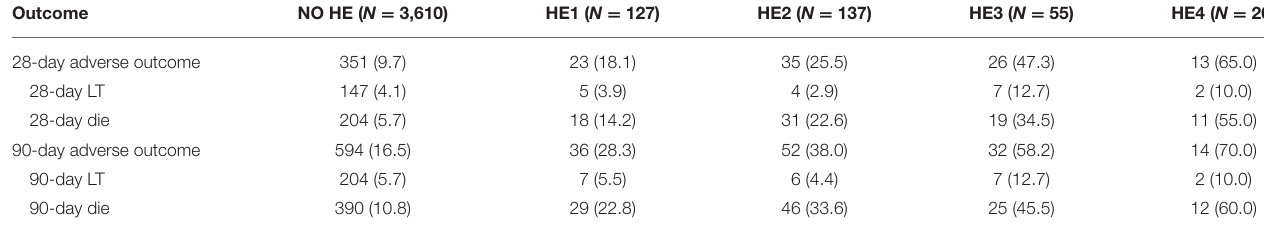
TABLE 2 | Association of HE grade with 28-day outcome and 90-day outcome of AoCLD patients.